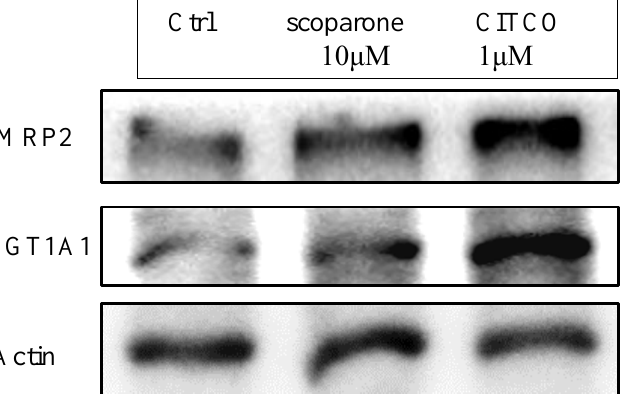
Figure 2. CAR downstream signal protein expression after treatment of CITCO or scoparone.